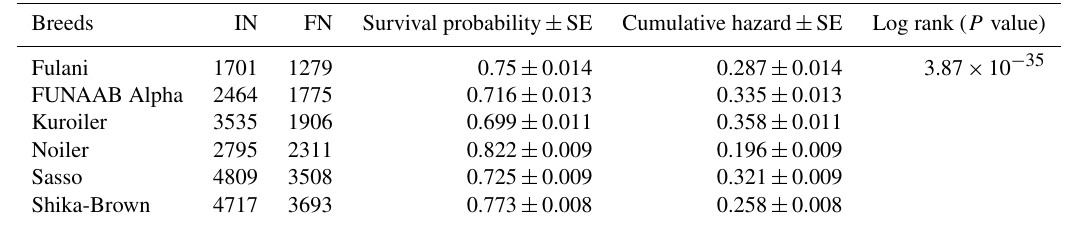
Table 10. Effect of breed on survival performance of female birds raised on-farm during laying phase in ACGG Nigeria project zones (20–72 weeks) (2016–2018).